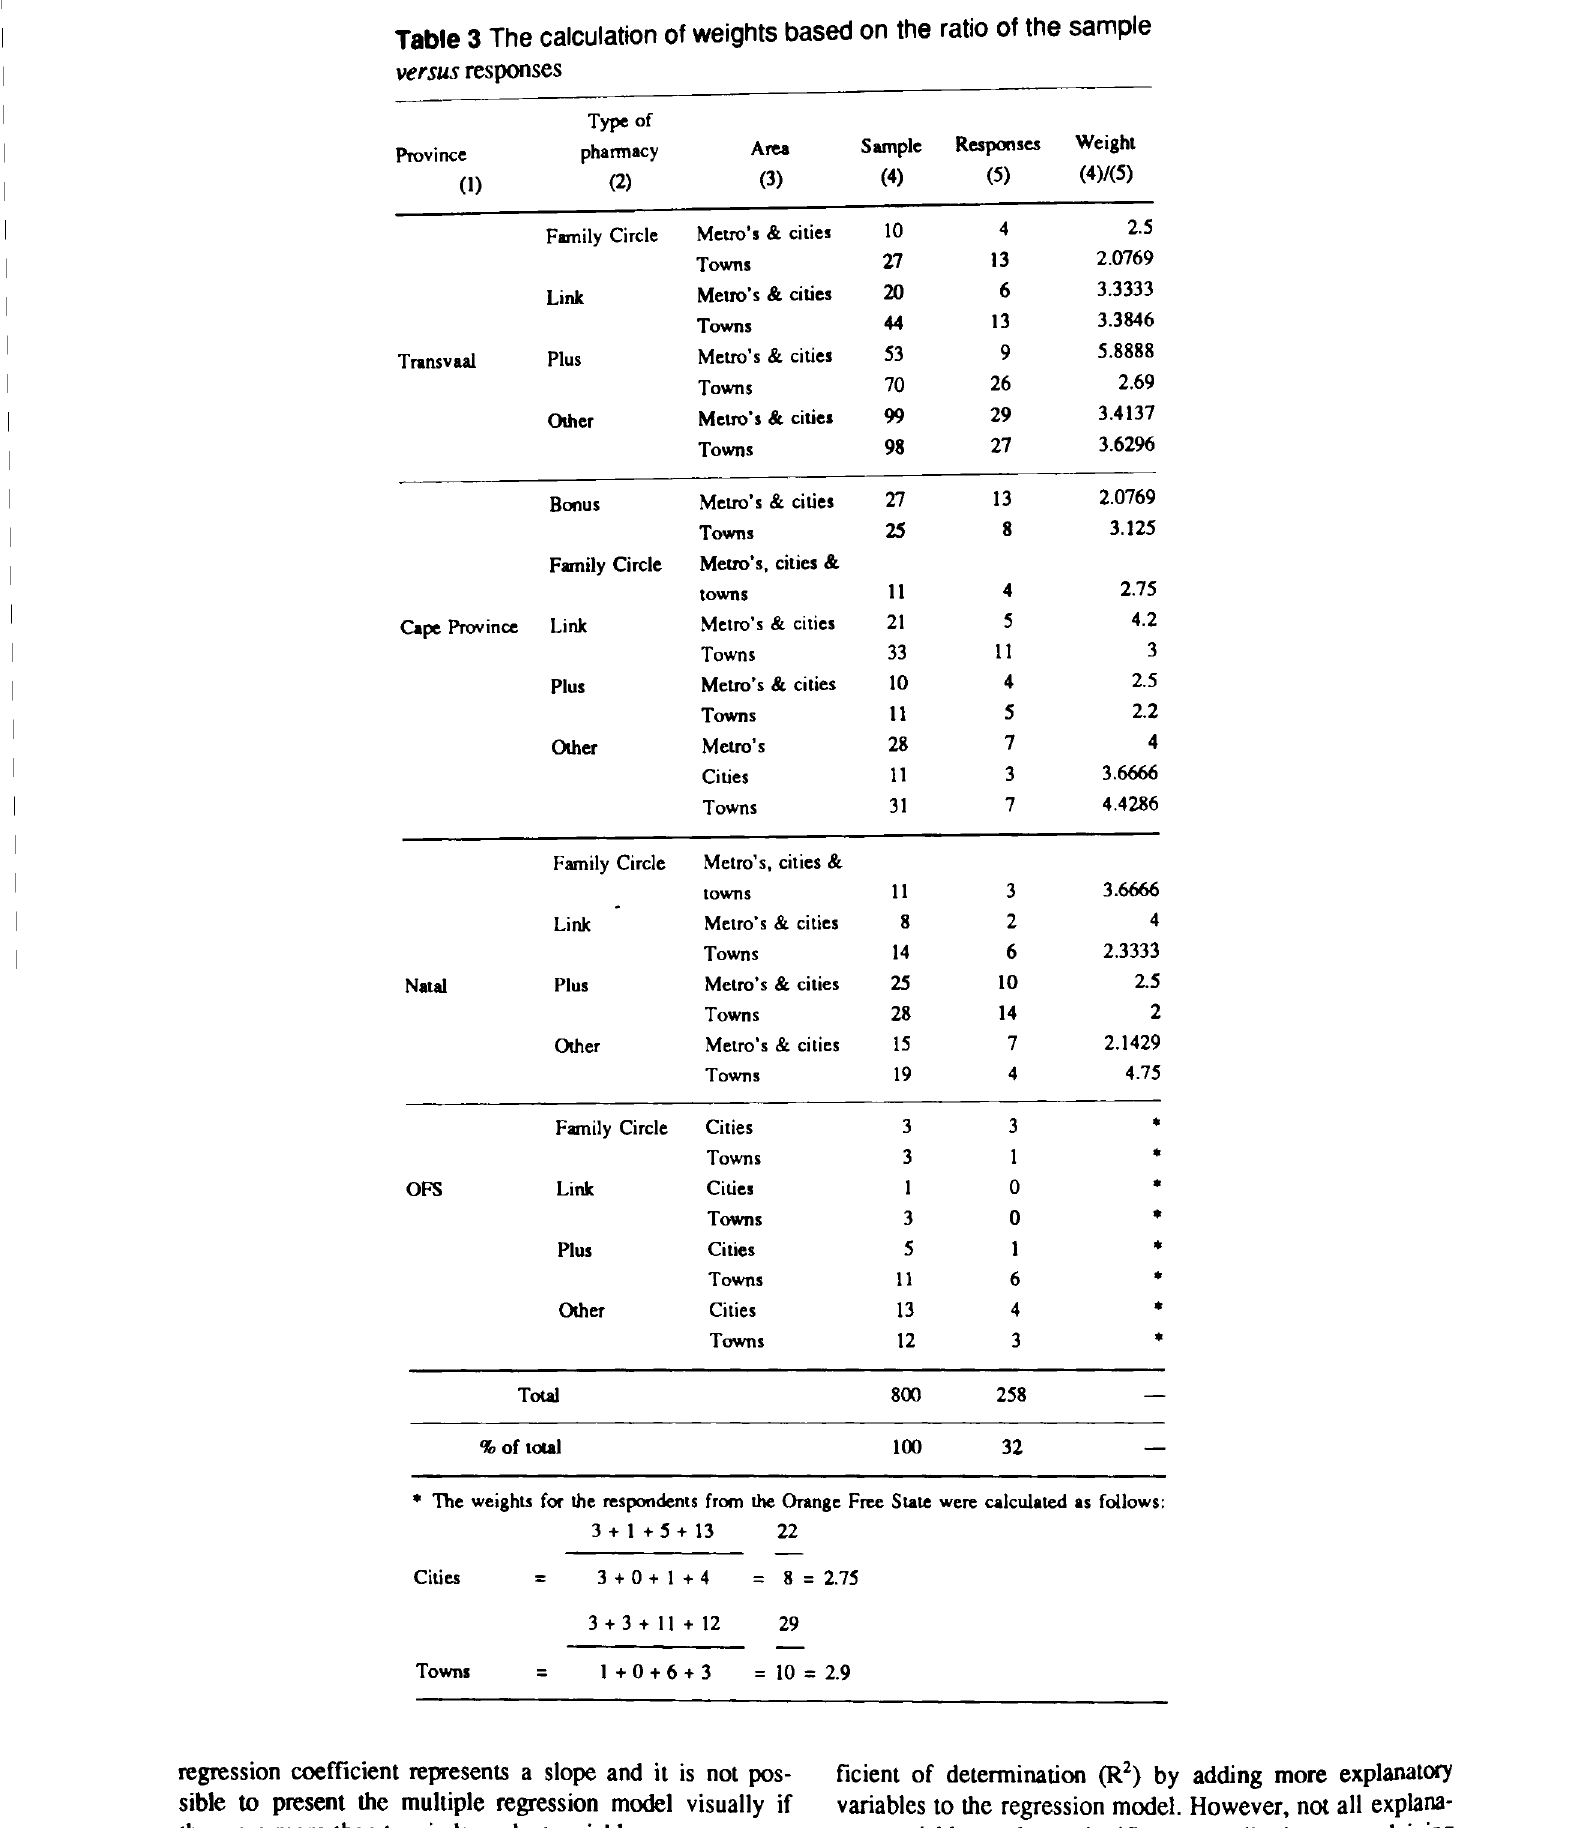
Table 3 The calculation of weights based on the ratio of the sample versus